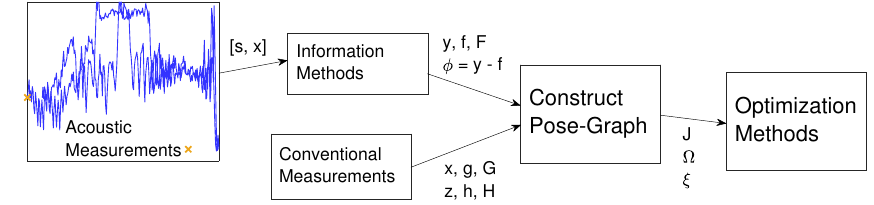
Figure 4. An illustrative block diagram outlining the process described in Section 3: the symbols on each arrow describe the variables output from the functions described by a block. Each symbol is defined within Section 3. A typical pose-graph optimization would optimize a pose graph constructed using conventional measurements. This work augments the pose graph with information from acoustic measurements. The iterative nature of the process is not illustrated; the whole process is repeated for each new estimated trajectory x output from the